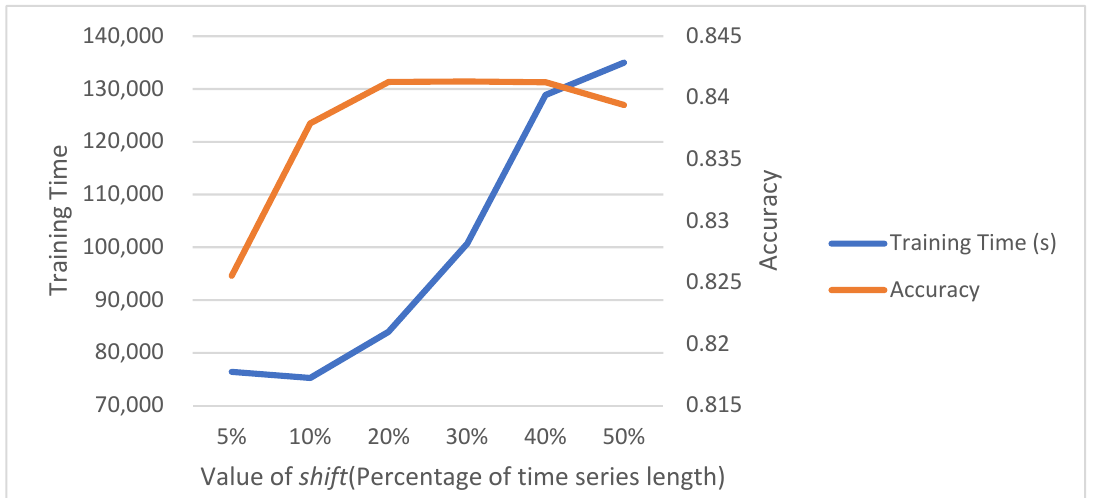
Figure 6. Average accuracy and training time of RSFCF over Small60 datasets under different settings of parameter shift.